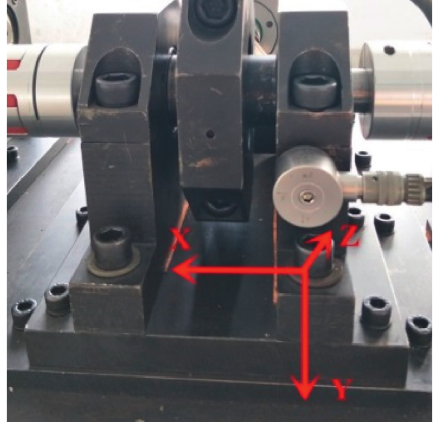
Figure 7: Arrangement of test points and vibration acceleration